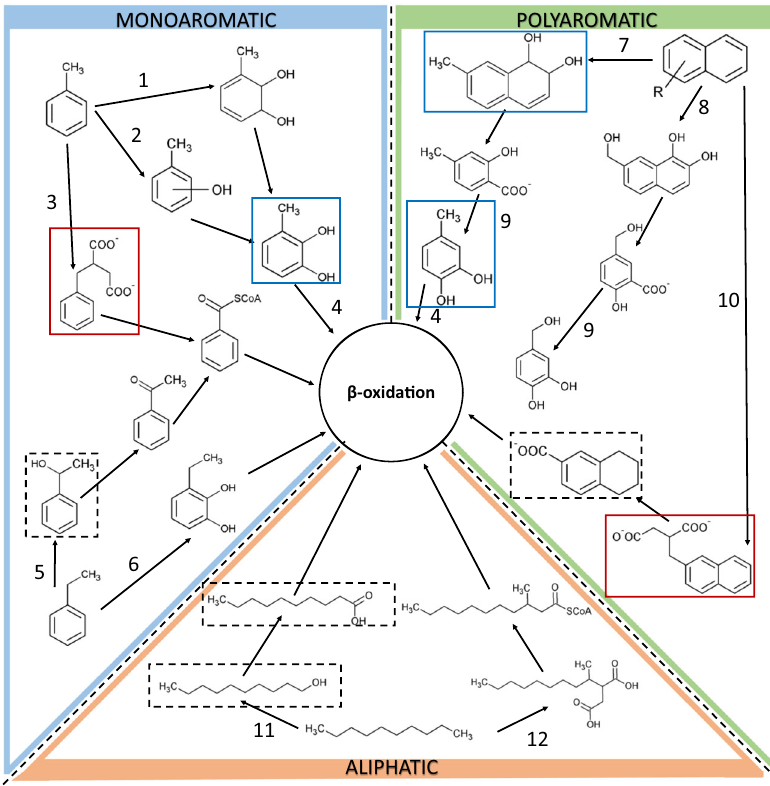
Fig. 4 Analysis of fuel metabolites within Ship #1 and Ship #3 ballast tank fl uids. Blue boxes indicate compounds identi fi ed in Ship #1 only, red in Ship #3 only, and black were observed in both samples. Numbers above arrows correspond to transformations catalyzed by metabolic genes listed in Fig.